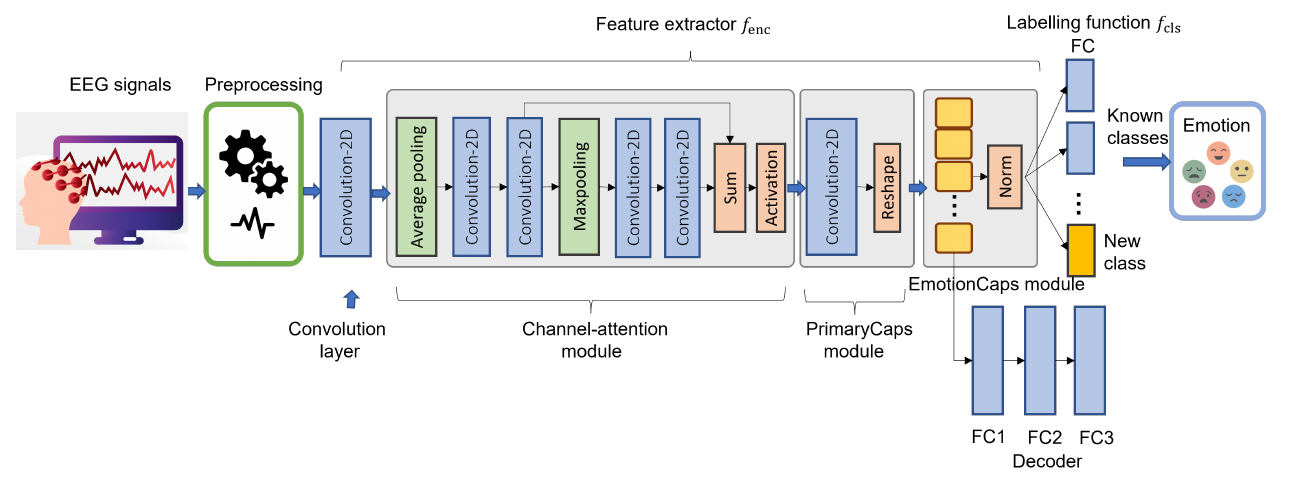
Figure 2. Diagram of the Capsule Network architecture.